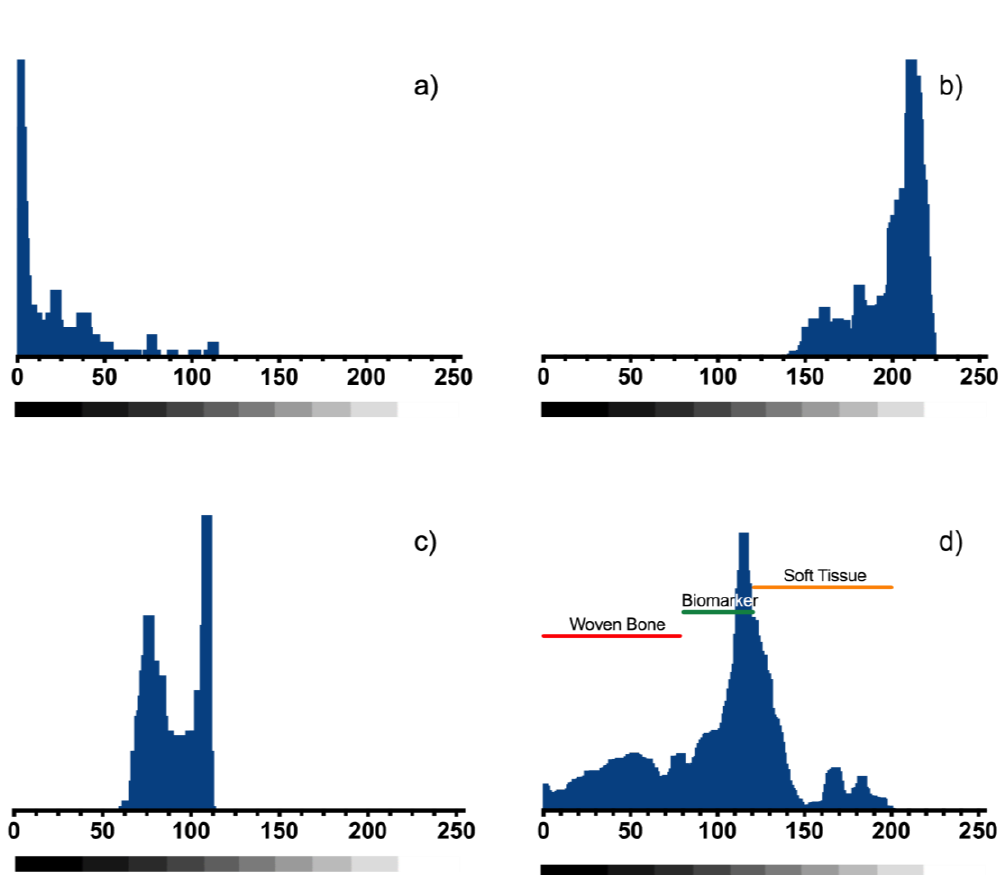
Figure 10. Grayscale values histogram analysis made from zoom image of Figure 9e. ( a ) Woven bone histogram, ( b ) BM-2 marker histogram, ( c ) soft tissue histogram and ( d ) histogram of the complete image and values were the image components (woven bone/BM-2/soft tissue) could be discriminated from each other, these values are presented in Table 3.